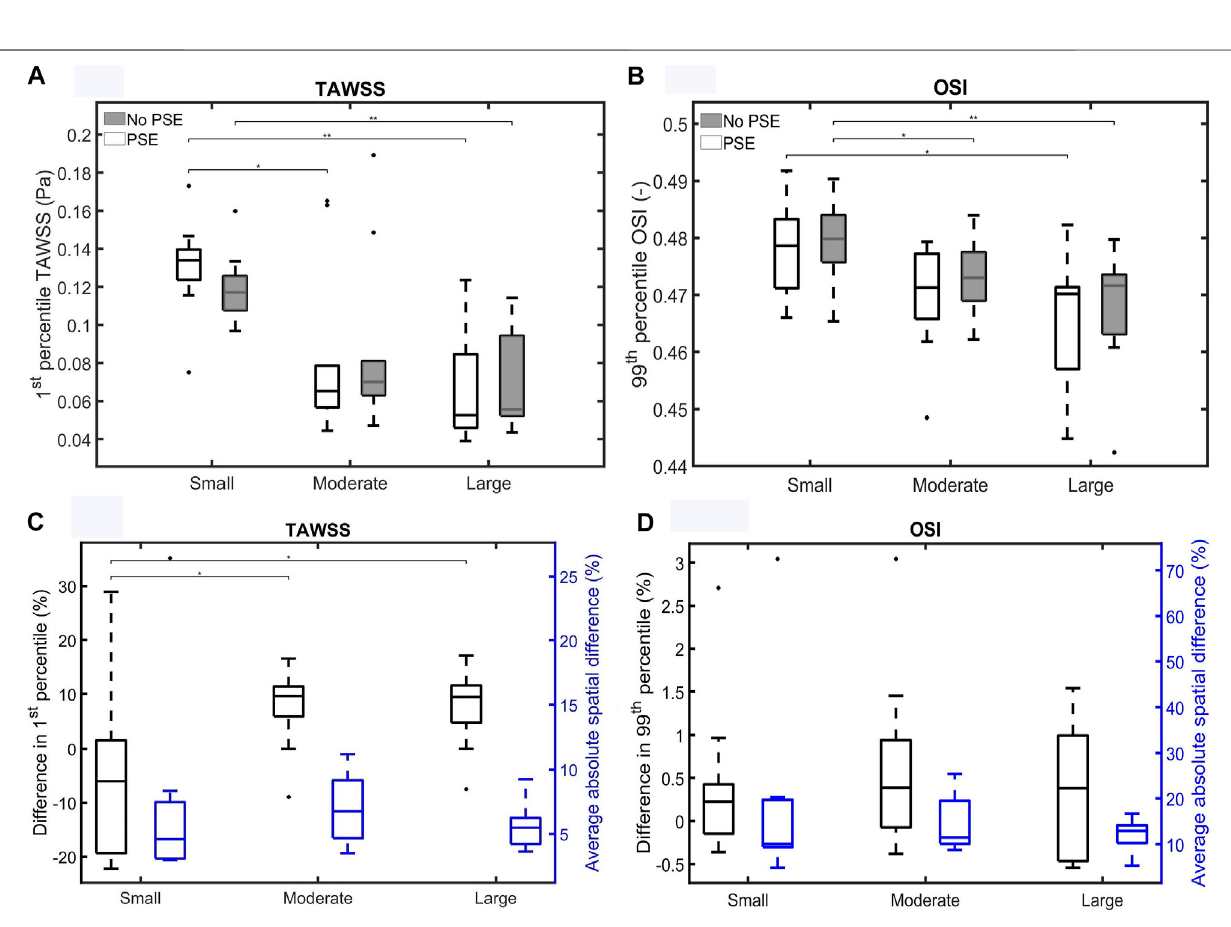
The 99th/1st percentile values and spatial differences in displacement, stress, TAWSS, and OSI for each individual patient are summarized in Supplementary Tables S2, S3 , respectively. ”